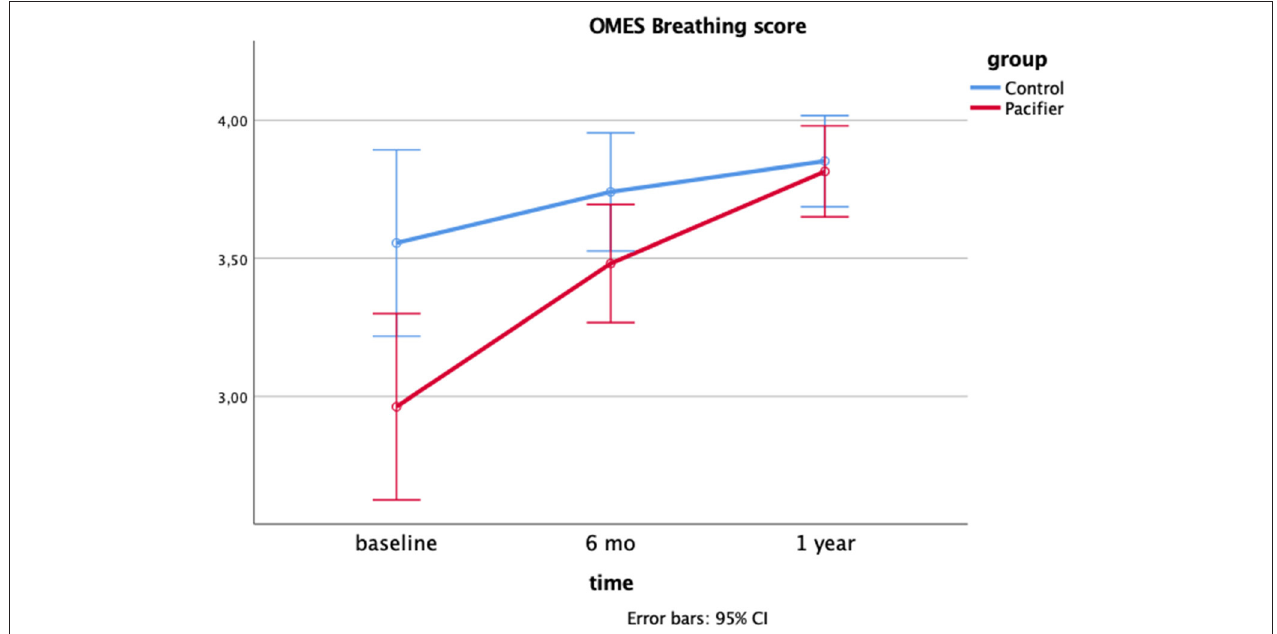
FIGURE 5 | Interaction effect time*group on the OMES Breathing score after 1-year follow-up: a two-way Mixed model ( p = 0.023; eta partial squared = 0.07; power = 69%).